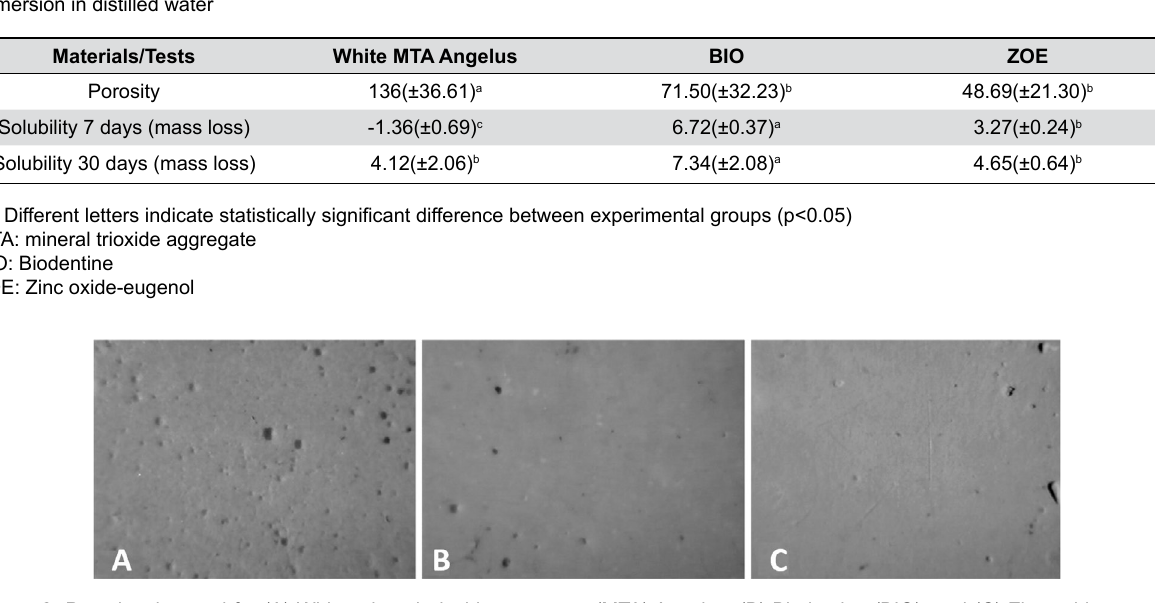
Figure 2- Porosity observed for (A) White mineral trioxide aggregate (MTA) Angelus, (B) Biodentine (BIO), and (C) Zinc oxide-eugenol (ZOE) cements using microscopic evaluation at 50x